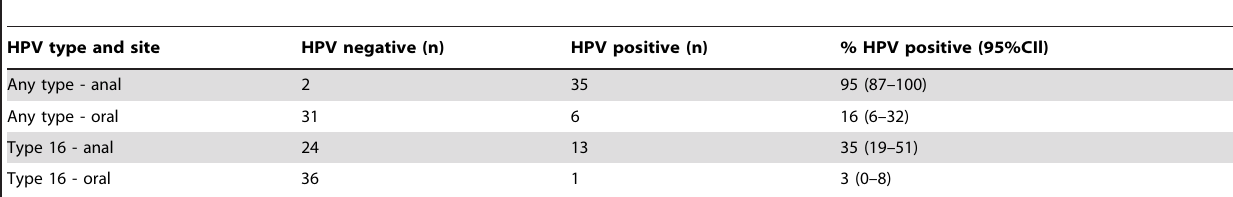
Table 5. HPV results in 37 HIV positive men from this study, who were tested for anal HPV in another ongoing study after a mean of 16